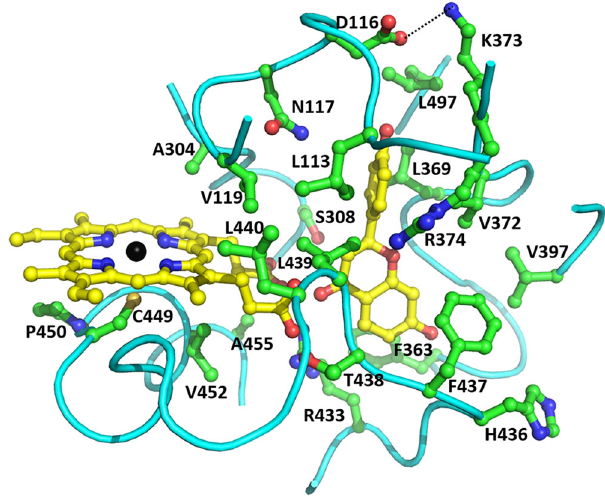
Fig. 4 The substrate-binding pocket and interactions of 2-HIS with docked substrate liquiritigenin. Substrate liquiritigenin and heme are shown as ball-and-stick models with carbon atoms colored in yellow and iron atom in black. Some amino acid residues in the substrate binding pocket within ~4.5 angstroms from substrate are labeled and shown as ball- and-stick models with carbon atoms colored in